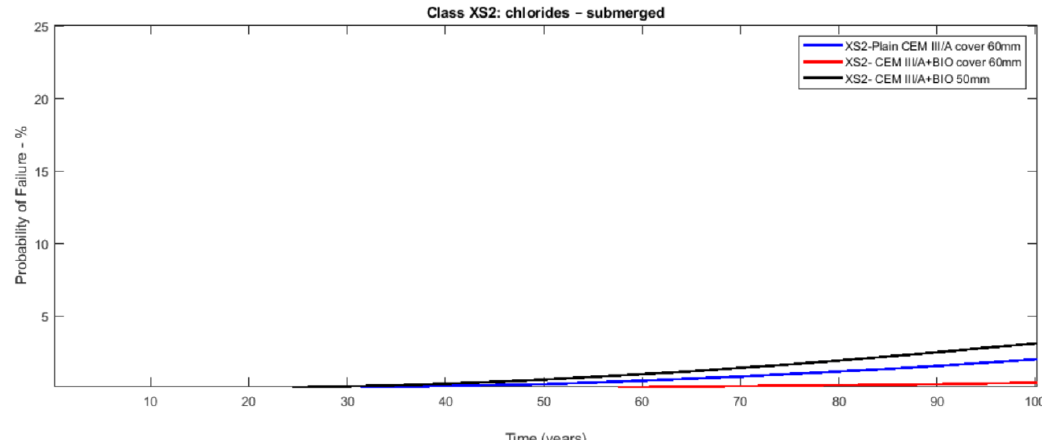
Figure 3. Probabilistic service life results of CEM III/A concrete—exposure class XS2 (submerged)—without and with bioproduct for a cover of 60 and 50 mm.